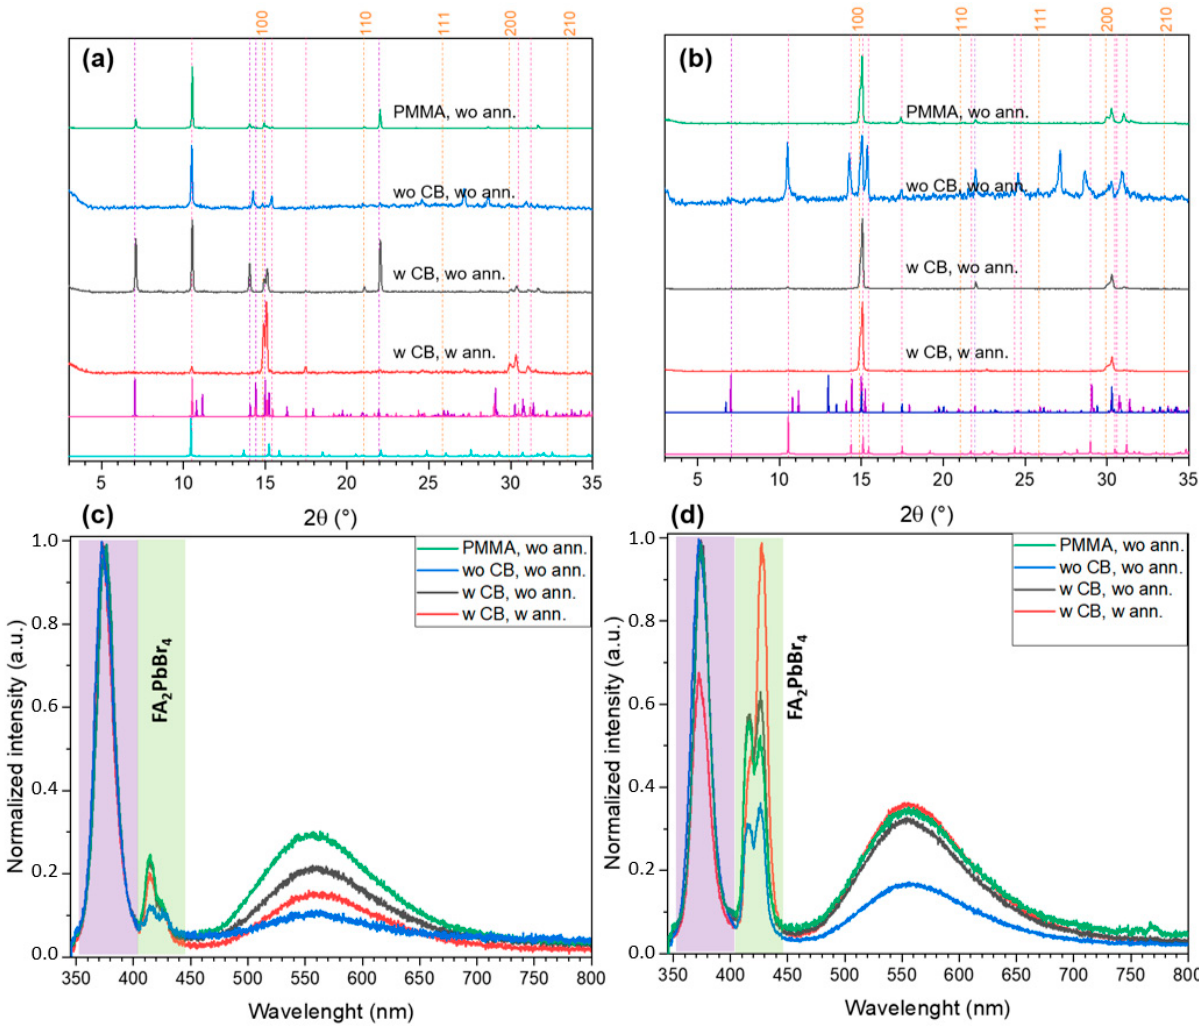
Figure 8. The XRD patterns ( a , b ) and PL spectra ( c , d ) of thin films with FABr:PbBr 2 3:1 spin-coated at different conditions from DMSO ( a , c ) and DMF ( b , d ) solutions. The dashed orange lines denote the reflections of FAPbBr 3 perovskite, other dashed lines indicate the positions of the most relevant reflections corresponding to reference XRD pattens plotted below (FA 3 PbBr 5 by magenta, t -FA 2 PbBr 4 by vivid violet, FA 2 PbBr 4 · DMSO by turquoise, m -FA 2 PbBr 4 by dark